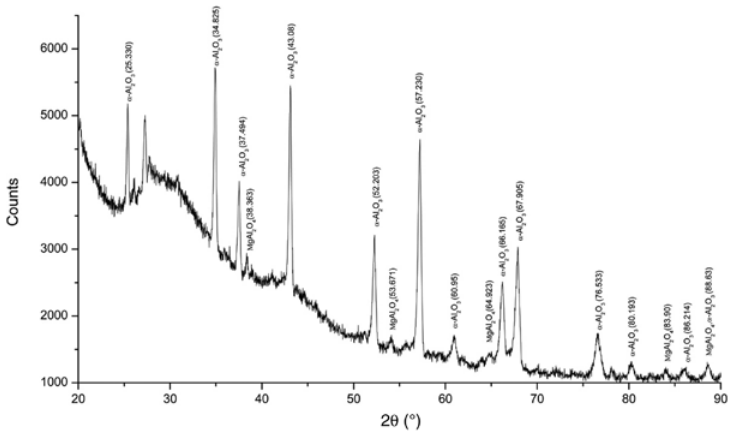
O , synthesized at 85 ° C. 2 5